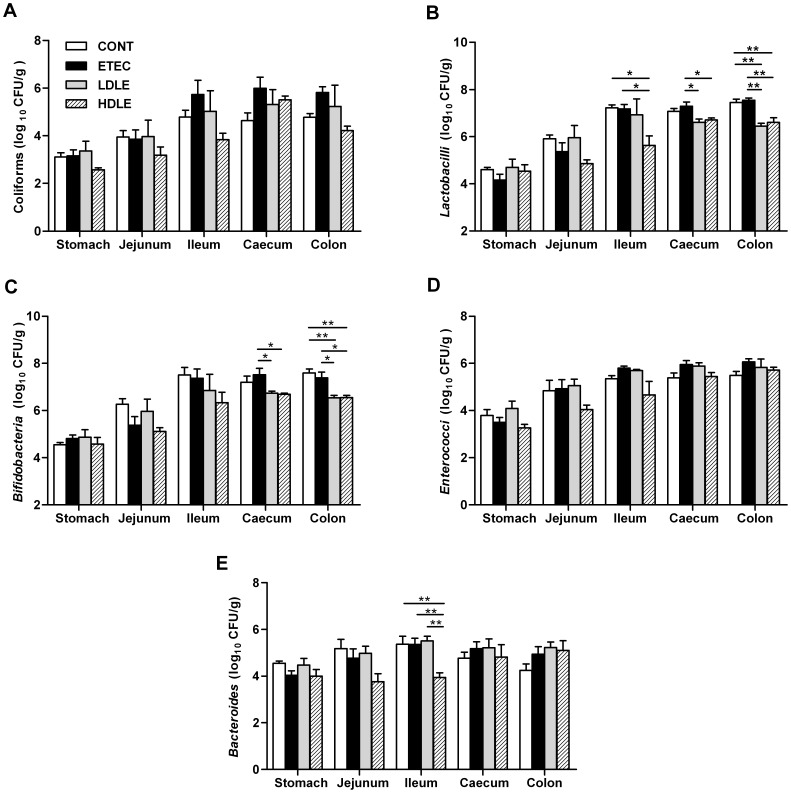

Lactobacillus rhamnosus consumption shaped the composition of intestinal microbiota during F4+ETEC infection.(A) Coliforms, (B) Lactobacilli, (C) Bifidobateria, (D) Enterococci and (E) Bacteroides. The contents from the stomach, mid-jejunum, distal ileum, caecum and mid-colon were collected at day 15 after weaning (1 week after F4+ETEC challenge) for microbial cultures. Results are presented as log10 CFU/g contents, and all counts were performed in triplicate. Data are presented as means ± SEM (n = 5 per group). *P<0.05; **P<0.01.